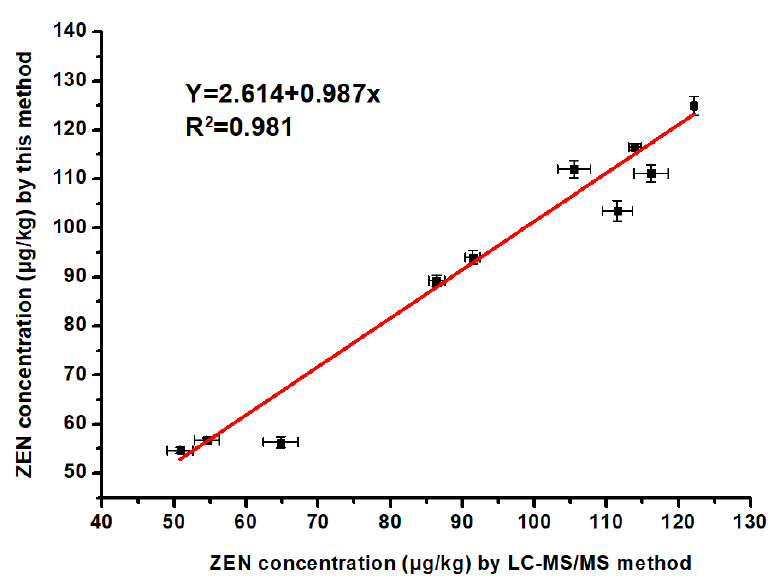
Figure 5. Comparison of determination results of 10 naturally contaminated samples analyzed through the CuO NP-based method and LC-MS/MS ( n = 3).